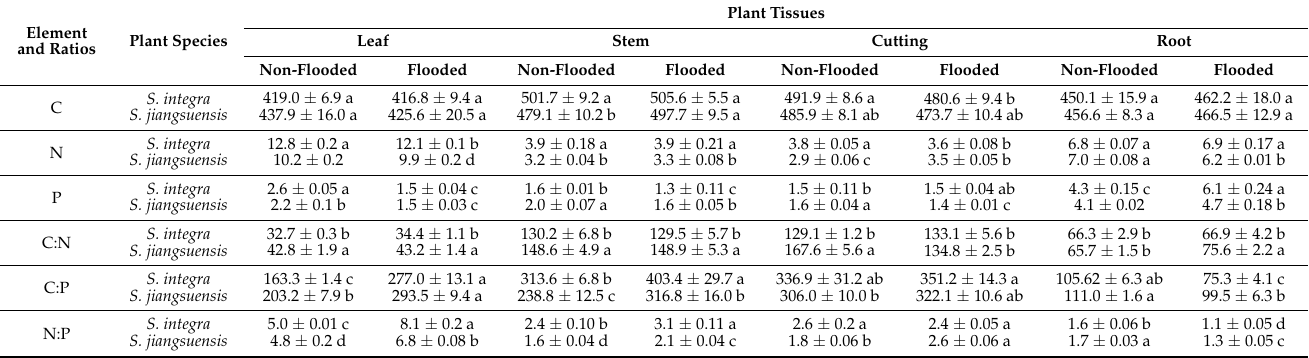
Each value represents the mean of four replicates ± standard deviation. Different letters indicate significant difference among the 4 treatments (2 willow species under non-flooded and flooded conditions) at the 0.05 level by Fisher’s. Results of a two-way ANOVA are presented in Table